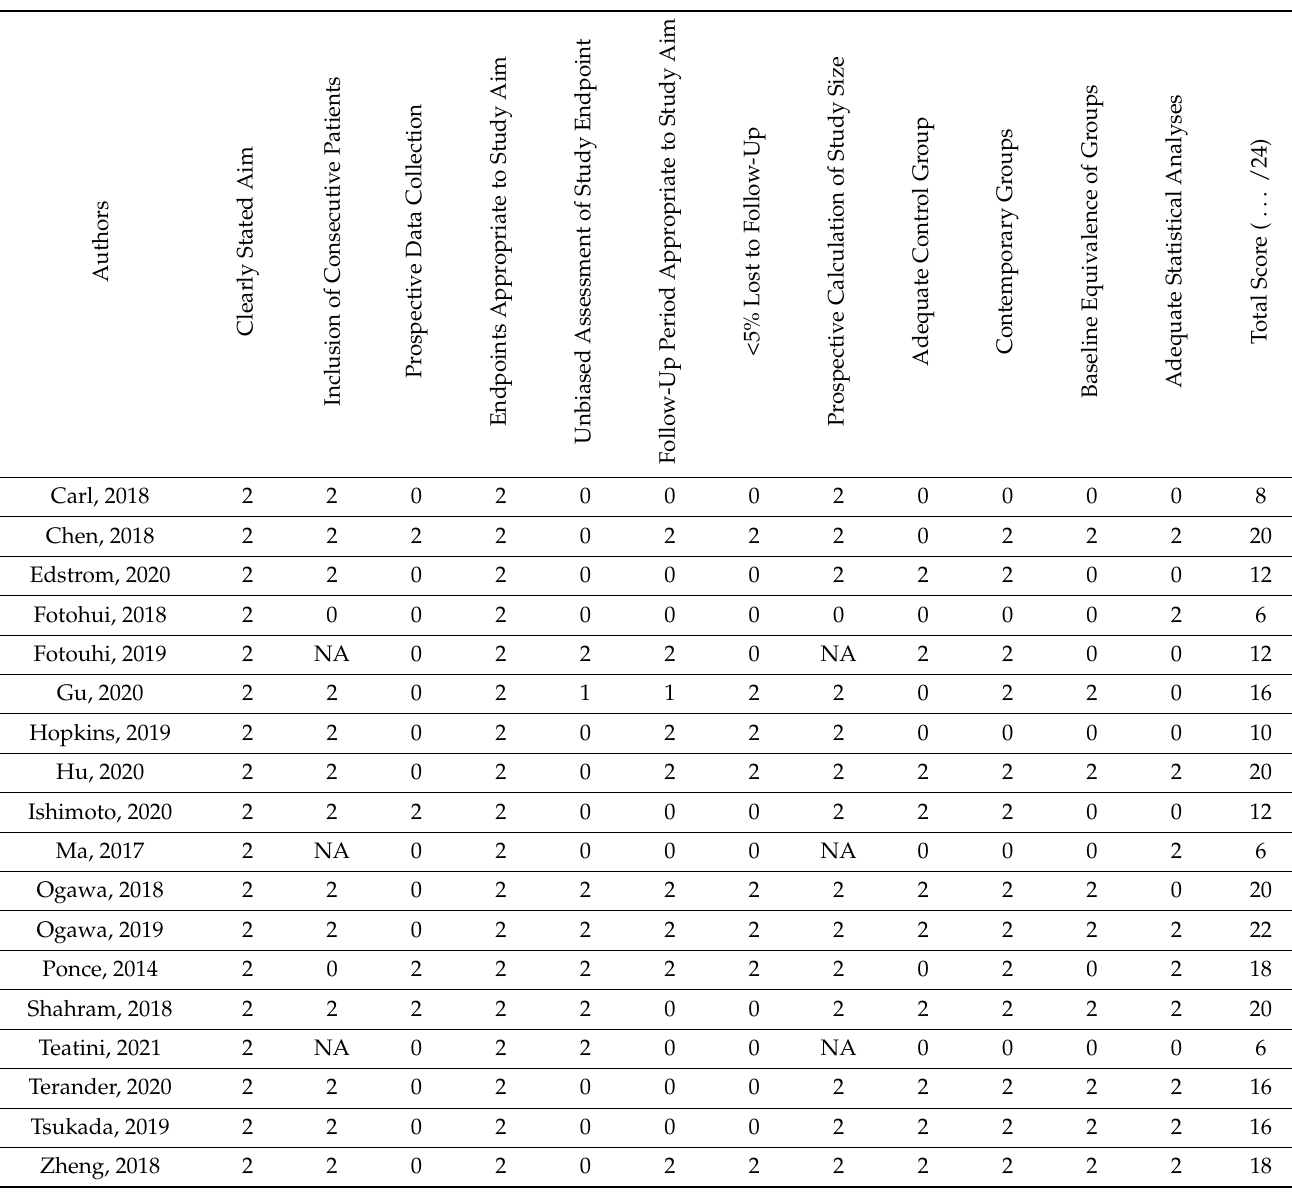
Table 2. MINORS tool for assessing the risk of bias in non-randomized